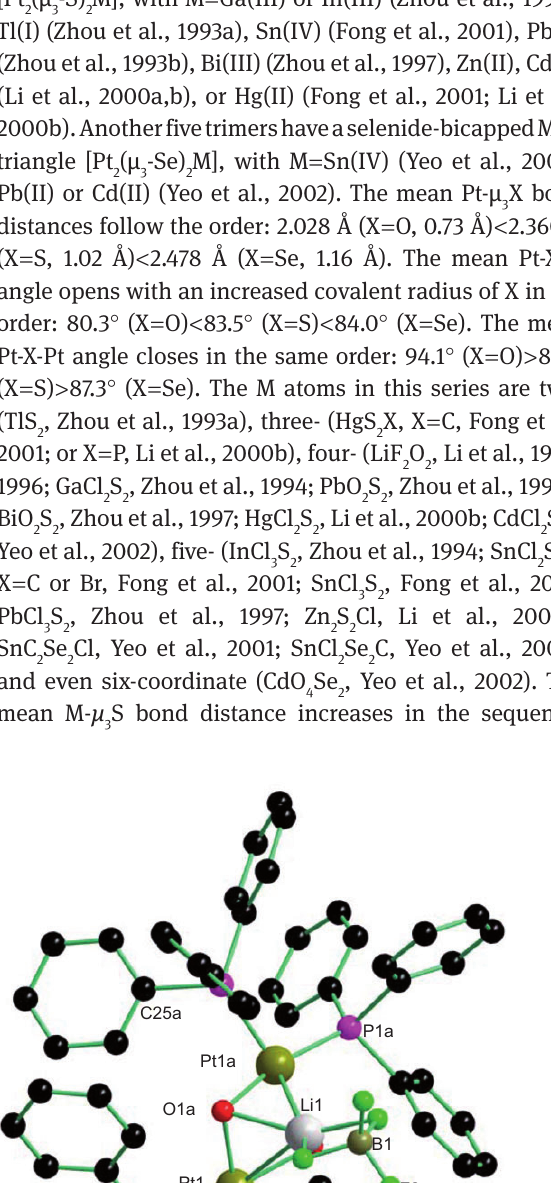
] Zn } (Poat et al., 2 2